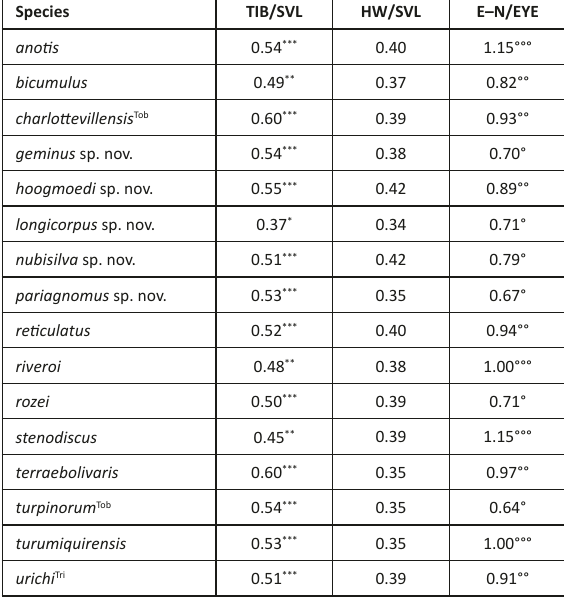
Table 4. Ratios of key measurements for species of Pristimantis from the Península de Paria, Trinidad (Tri), and Tobago (Tob). Measurements used are from the holotype of each species. For TIB/SVL we consider species with ratios ≥ 0.50 as long-legged (***), those with ratios between 0.40 and 0.49 as having moderately long legs (**), and those with ratios < 0.40 as short-legged (*). Similarly, we divide E–N/EYE ratios, as indicators of snout length, into three groups: those with long snouts (≥ 1.00; °°°), medium snouts (0.80–